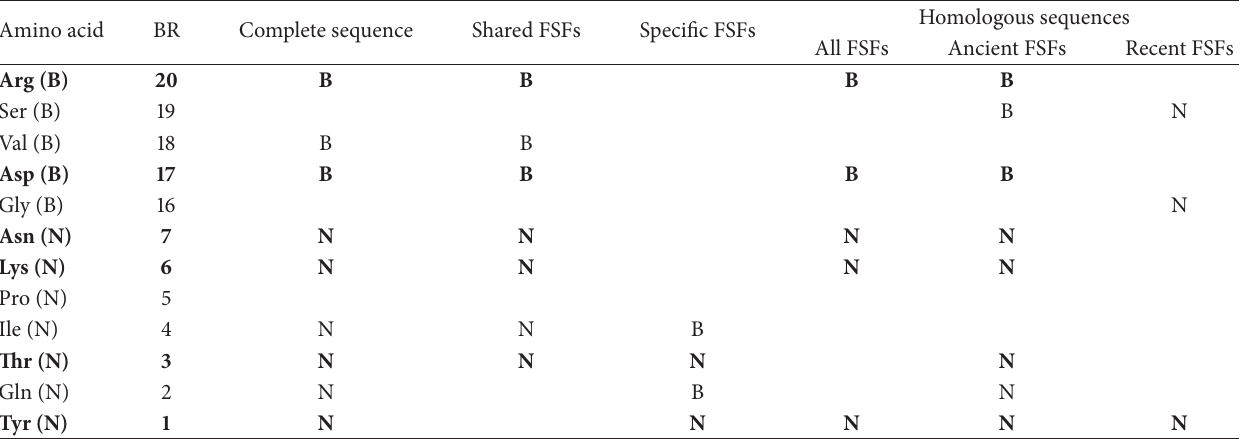
Table 2: Barophily rank (BR) and preference of the barophilic (B) and non-barophilic amino acids (N). Bold font identifies amino acids that have most consistent and significant preference that is congruent with their barophily or non-barophily